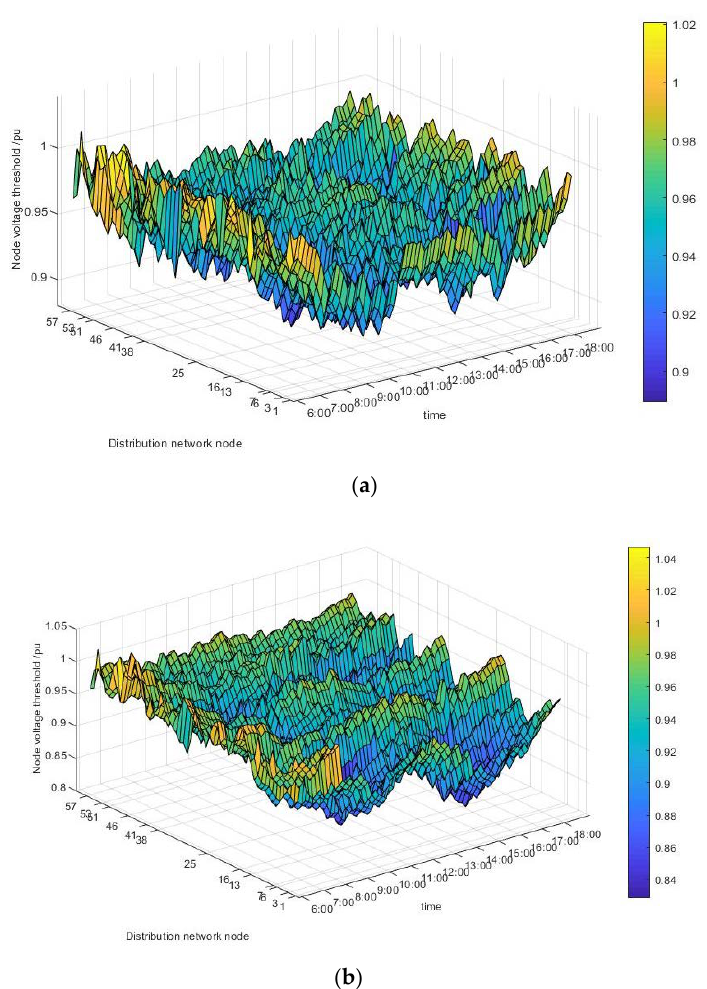
Figure 12. Distribution voltage distribution of 57-node distribution network in di ff erent scenarios. ( a ) 57-node distribution network voltage under the optimal charging path navigation; ( b ) voltage of 57-node distribution network without optimized charging